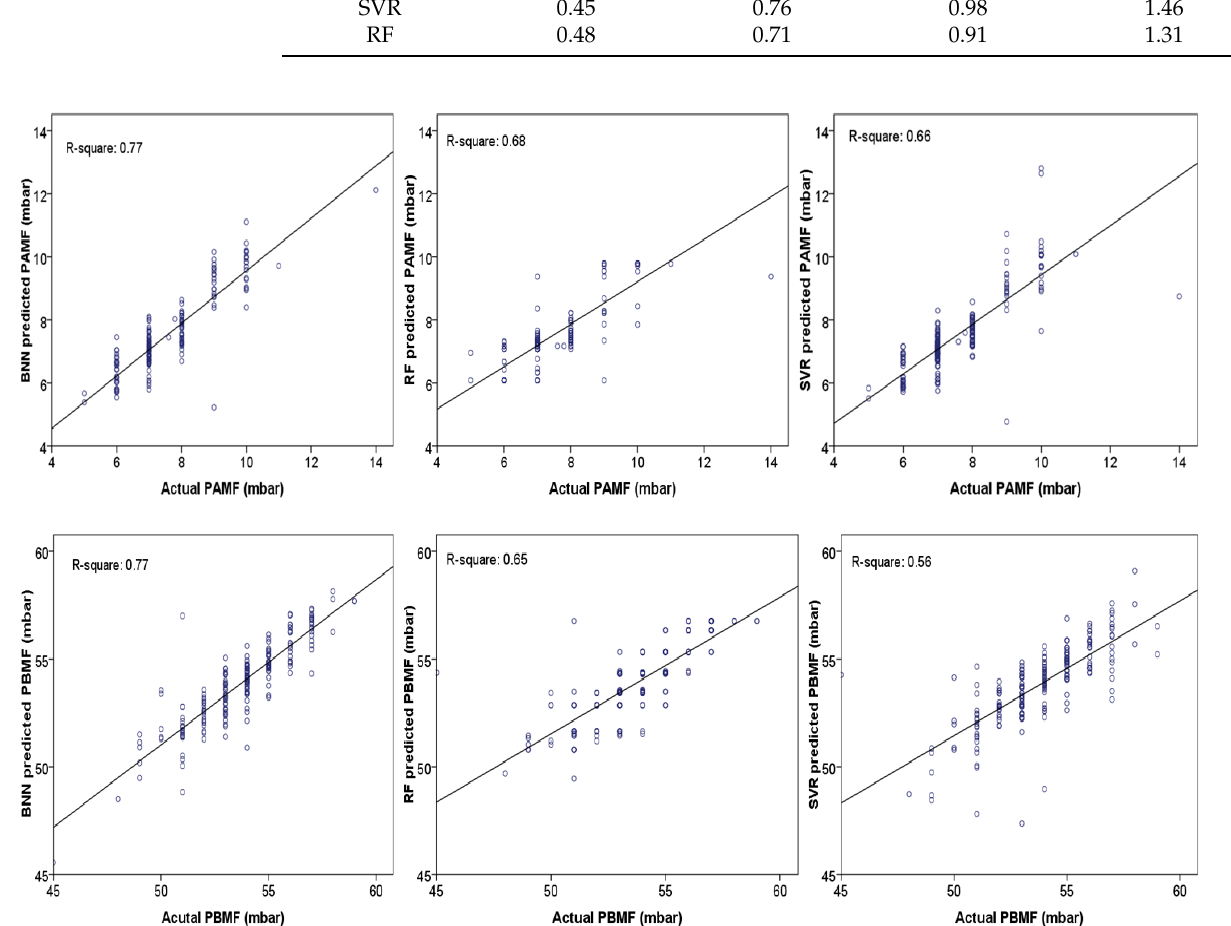
Figure 3. Coefficient of determination (R-square) for the different model outcomes in the testing stage.